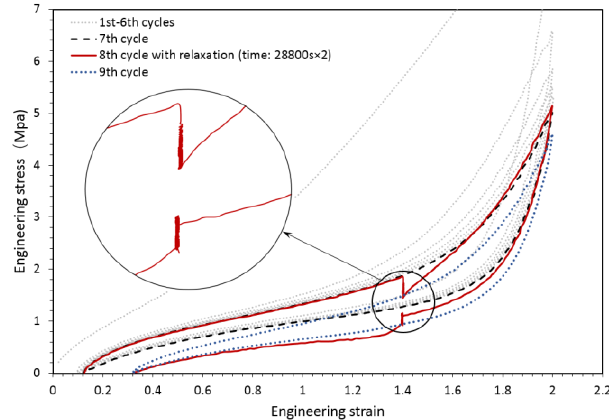
Figure 10. Cyclic tests with relaxation on